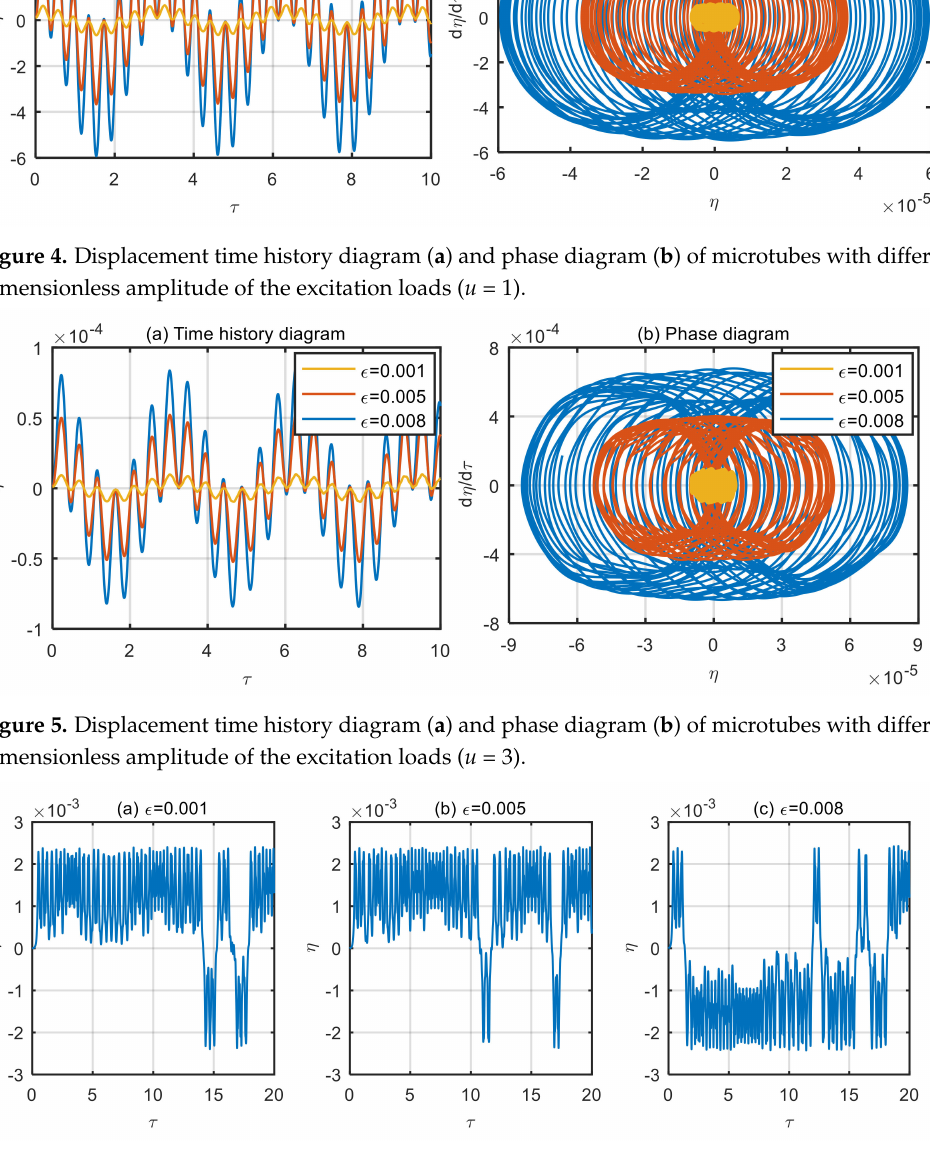
Figure 6. Displacement time history diagram of microtubes with different dimensionless amplitude of the excitation loads ( u = 10). ( a ) ε = 0.001; ( b ) ε = 0.005; ( c ) ε =